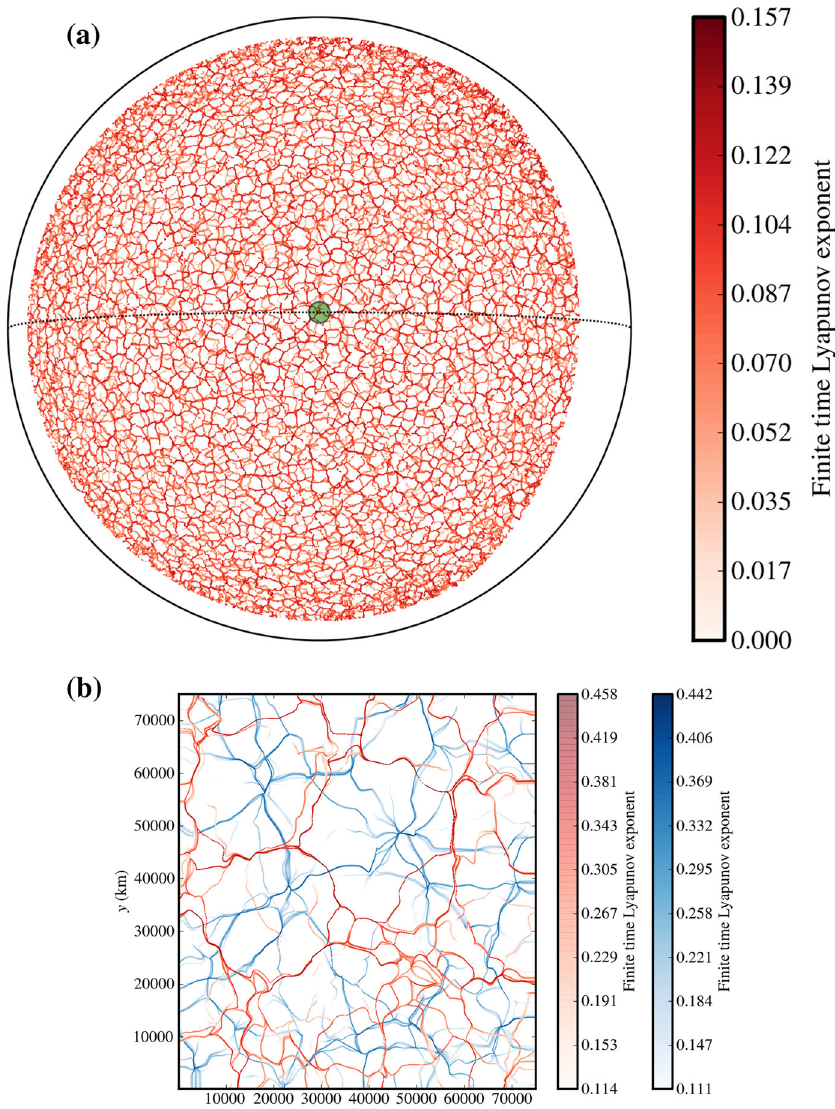
Fig. 18 a Global distribution of 24-h-positive time FTLEs of solar surface flows (in inverse hour units) computed from horizontal velocity field maps derived from October 8, 2010 SDO data (one of the quietest periods of solar activity since the launch of SDO). The green circle diameter is 30Mm. b Local distribution of FTLEs of solar surface flows computed from horizontal velocity field maps derived from August, 2007 Hinodedata,(red:positive-timeFTLEs,blue:negative-timeFTLEs).Imagecredits:F.Rincon&T.Roudier, so far